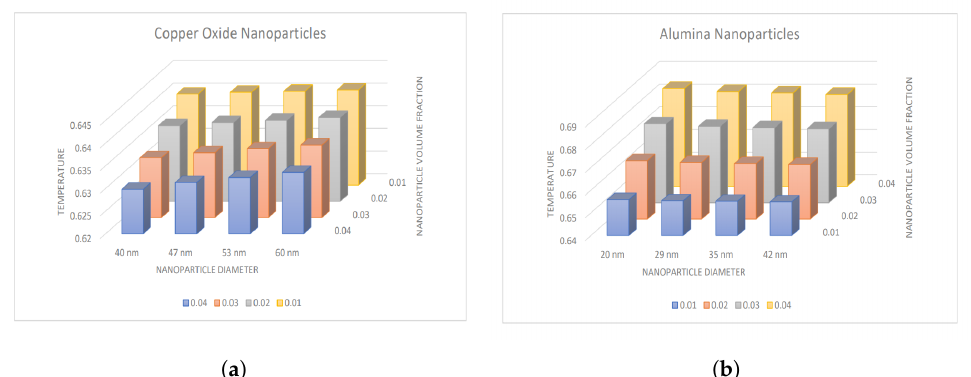
Figure 6. Variation in temperature with nanoparticle diameter and volume fraction for ( a ) CuO- nanoparticles, ( b ) Al 2 O 3 -nanoparticles.